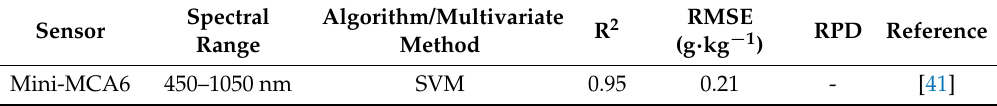
Table 3. Study for SOC estimation with the use of UAS.